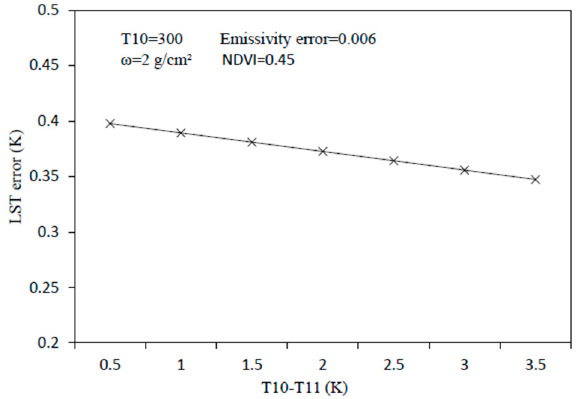
Figure 10. LST estimation error of the split window algorithm in the case of different T (cid:2869)(cid:2868) – T (cid:2869)(cid:2869) as a result of the estimation error in LSE.